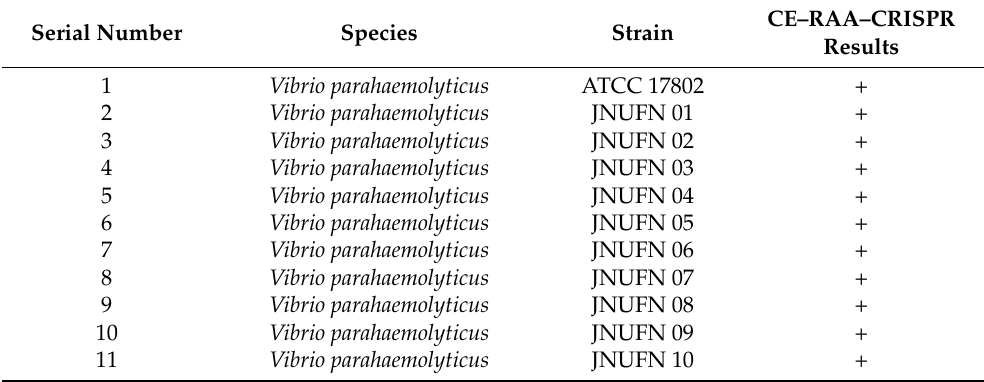
Table 1. Bacterial strains used for the evaluation of the specificity of CE–RAA–CRISPR in this study.